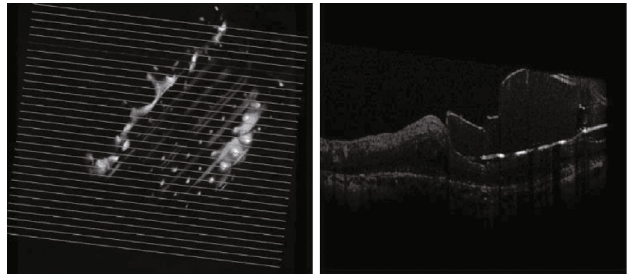
Figure 1: OCT image of the patient after Argus implantation.